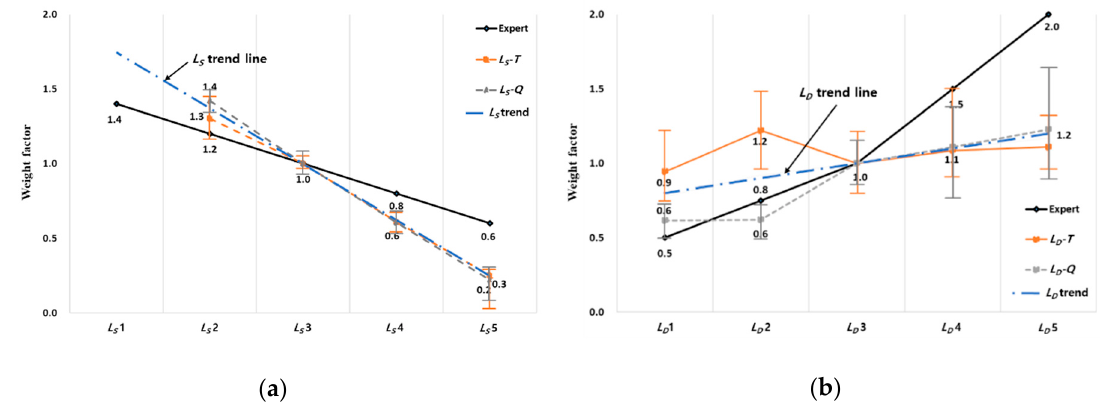
Figure 8. Weight factor trends: ( a ) L S weight factor trend from the test results; ( b ) L D weight factor trend from the test results.